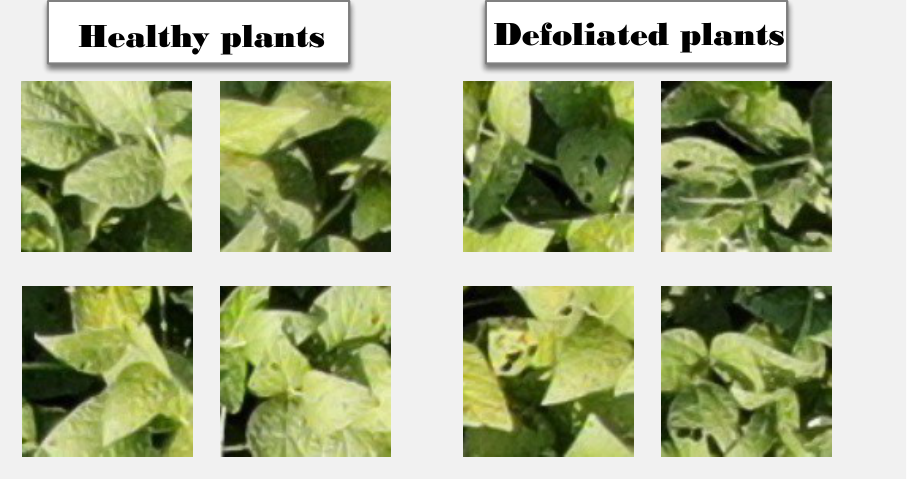
Figure 2. Example of images in the dataset. Images on the left are labeled healthy, while those on the right are labeled defoliated